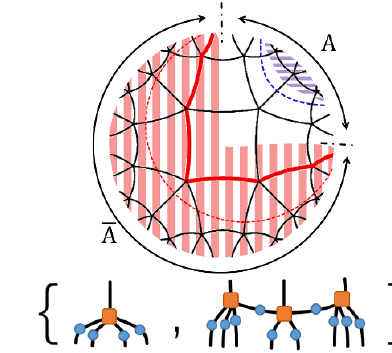
nh 1 i h 2 2 io ; . 4 2 2